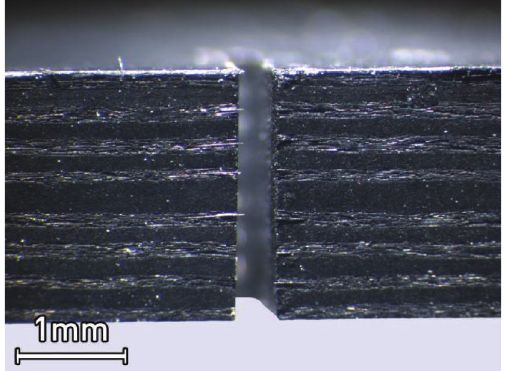
F 1: Stereoscopic side detail of a double-edge notched speci-